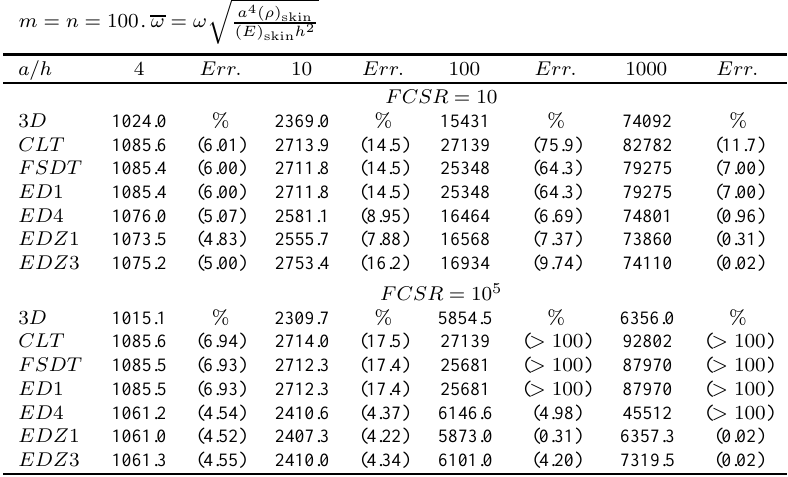
Table 4 Comparison of various theories to evaluate the fundamental frequency amplitude for the shell with Ren’s geometry. m = 0 and n = 1 . ω =